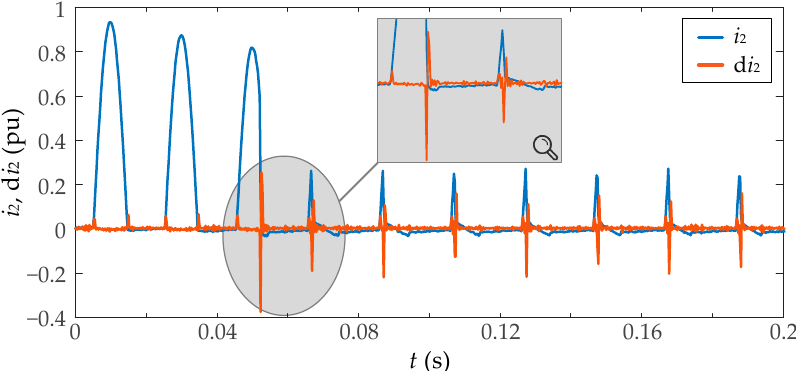
Figure 3. Second-order difference function (d i 2 ) of a saturated inrush current ( i 2 ), and an enlargement of both signals during the first two saturation intervals.